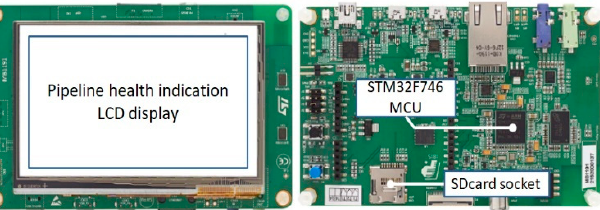
Figure 7. 32F746G-DISCOVERY board (tope view: left side—bottom view: right